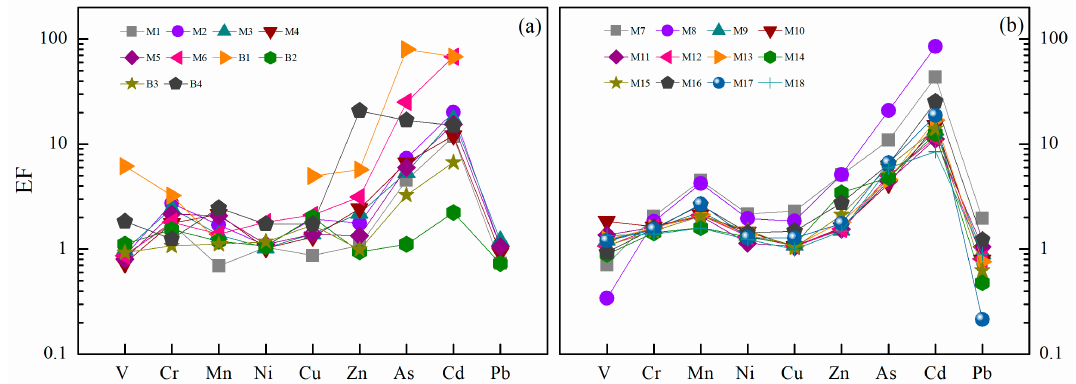
Figure 3. Enrichment factors (EF) of SPM in the Zhujiang River; ( a ) headstream, ( b ) downstream.